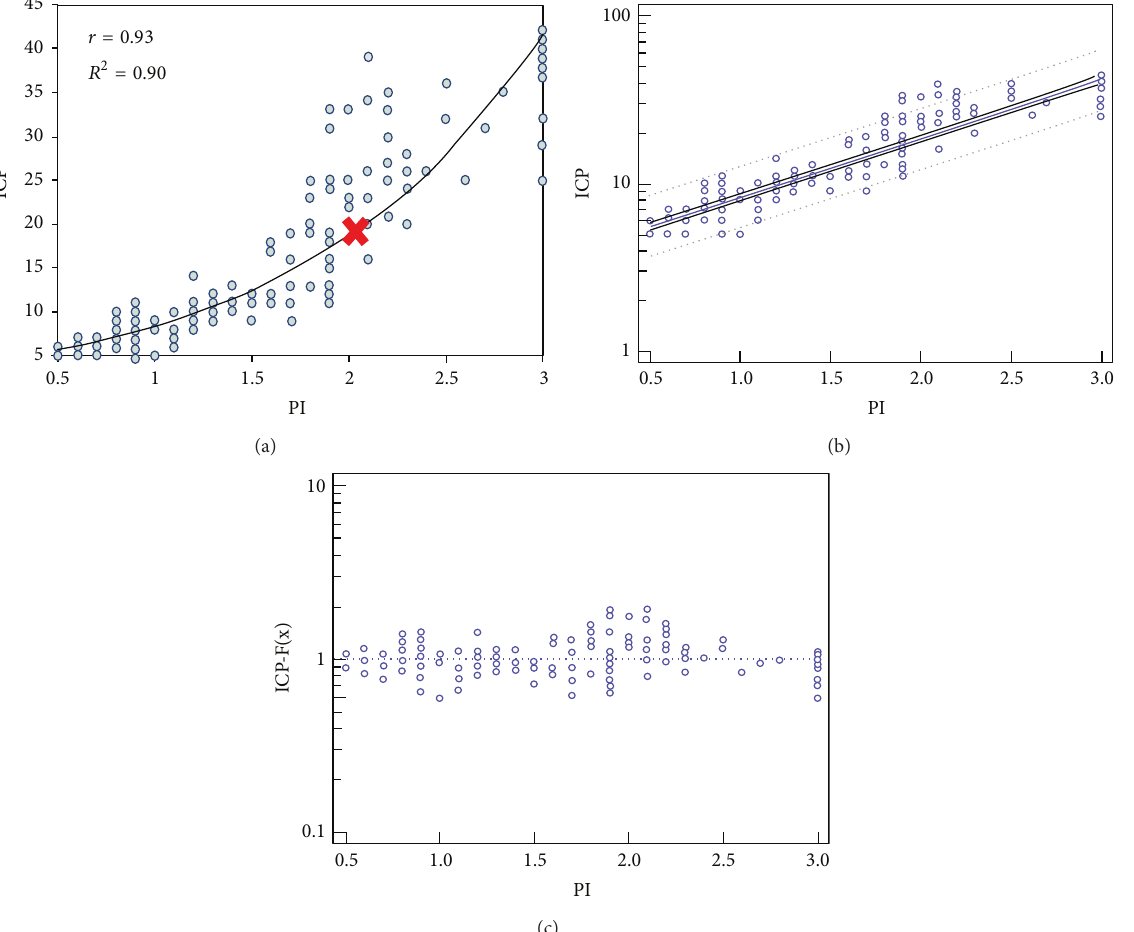
Figure 6: (a) Pulsatility index (PI) plotted versus the ICP (mmHg); the scatter plot displays a positive exponential relation between the two parameters rather than an exact linear relation. (b) Regression analysis model: the “dots” represent the actual measured values, while the blue line in the middle represents the estimated values by the model and the dashed lines represent 95% confidence intervals. (c) Goodness of fit for the model-driven prediction equation calculating the proximity of the predicted values (dots) to the actual measured values (dashed blue